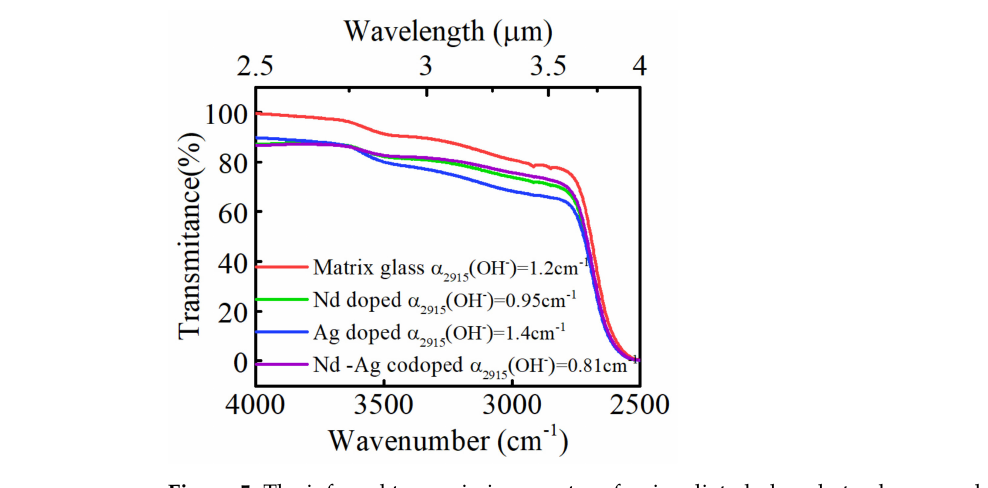
Figure 5. The infrared transmission spectra of unirradiated phosphate glass samples in the range of 2500–4000 cm − 1 (4–2.5 µ